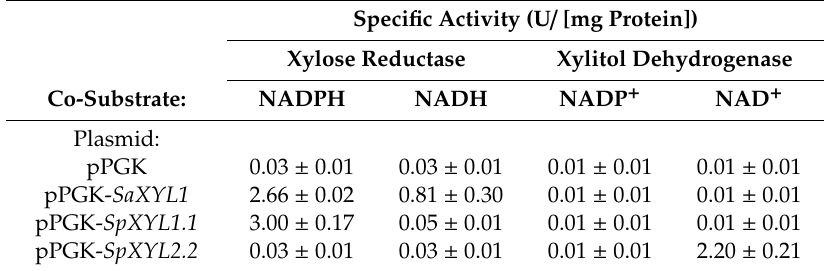
Table 3. Xylose reductase and xylitol dehydrogenase activities of cloned genes expressed in S. cerevisiae CEN.PK2-1C.